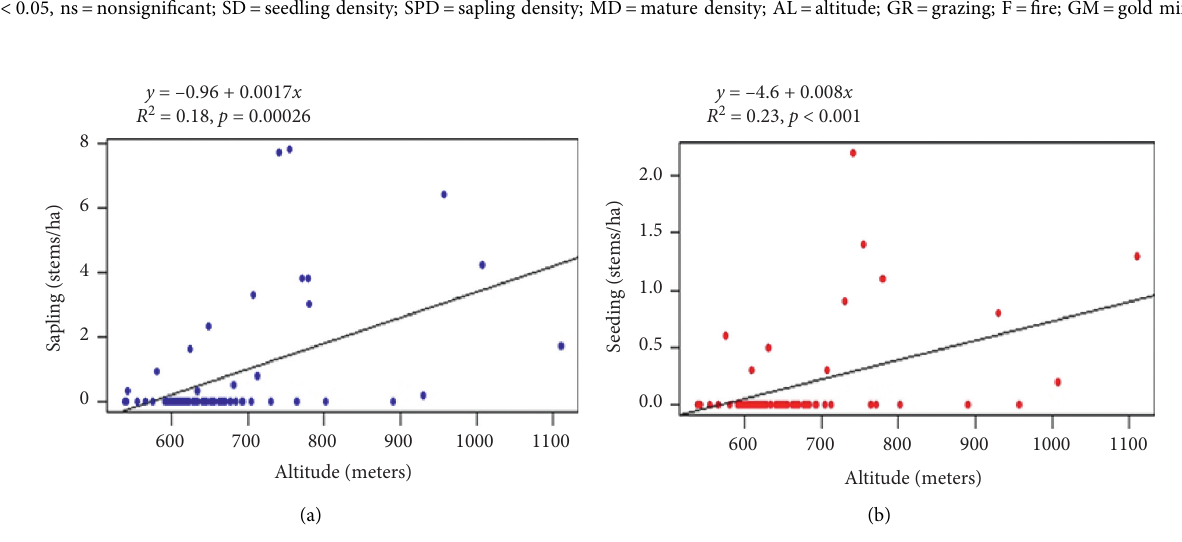
Figure 11: Scatter plots with least squares regression line showing the relationship between patterns of sapling (a) and seedling (b) density (stems · ha − 1 ) per plot and altitude